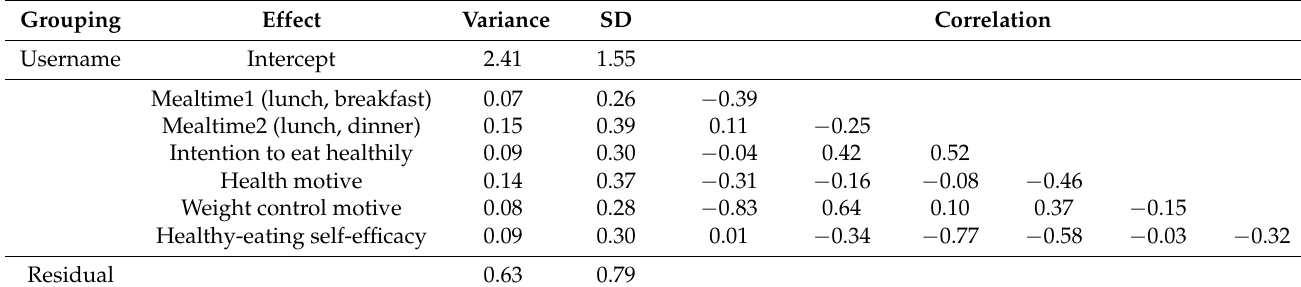
Table 4. Estimated model random effects.